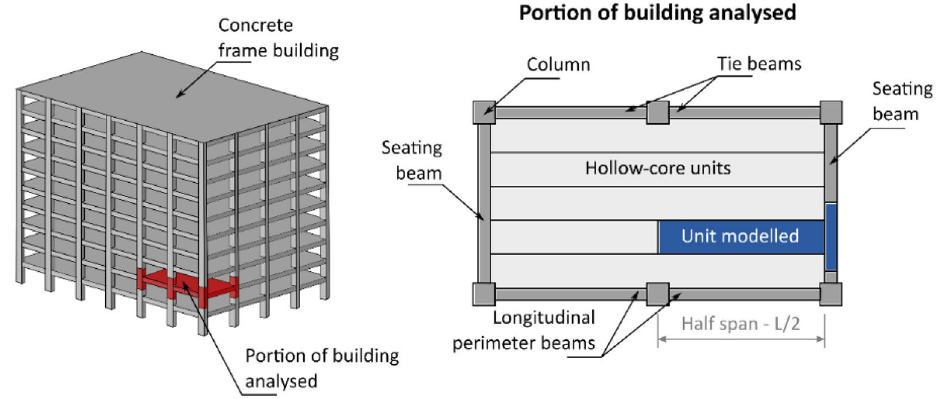
Fig. 4 PPHC sub-system origin [adapted from Jensen (2007)]